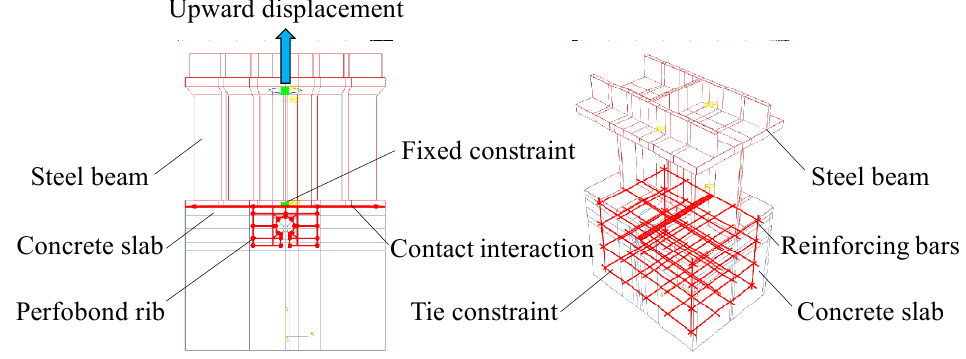
Figure 9. Interaction and boundary conditions.